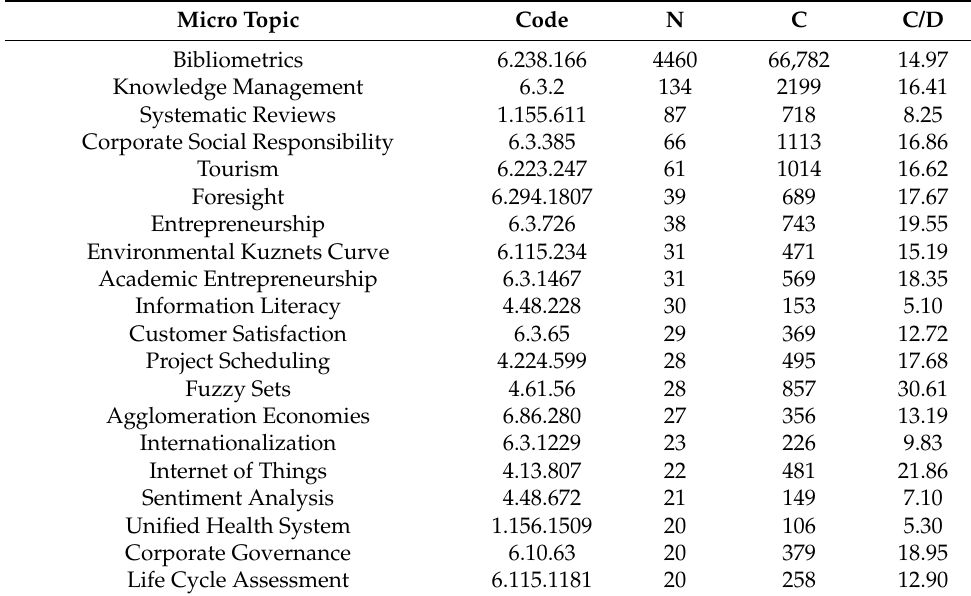
Table 7. Micro topics